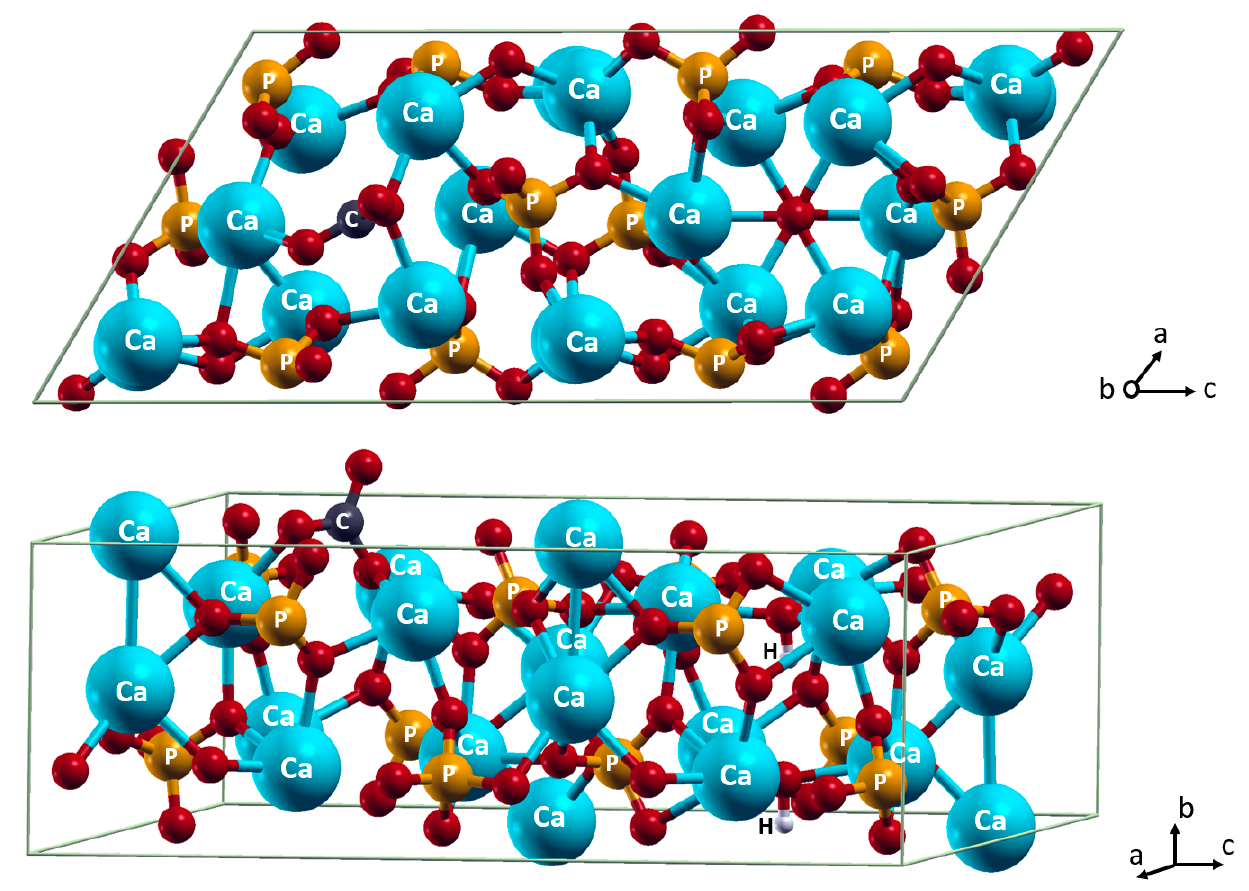
Figure 3. Incorporation of CO 32 − in A position. Color coding: Ca–cyan; P–orange; O–red; H–white; C–dark grey. For clarity, all atoms except oxygen are named.